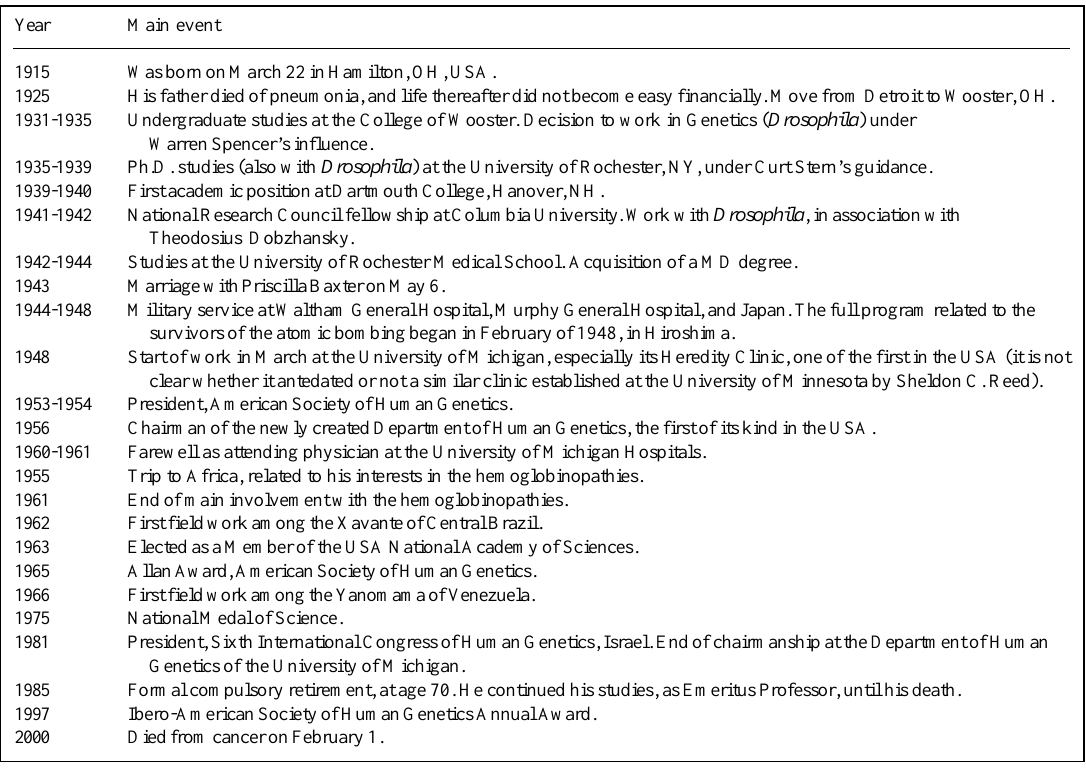
Table I - Main events related to the life of James V.